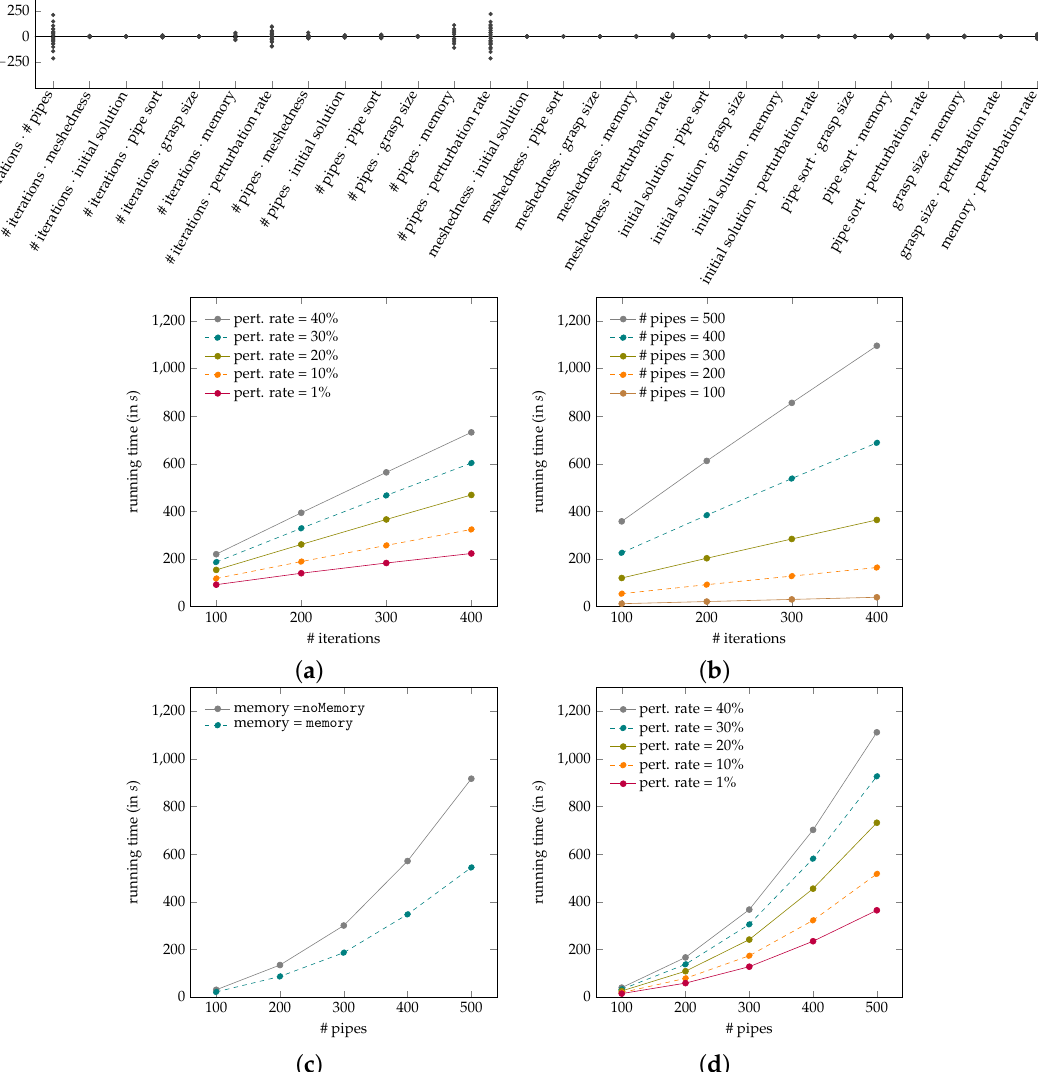
Figure 10. Values of the coefficients and mean plots for the regression model on the running time : main and interaction